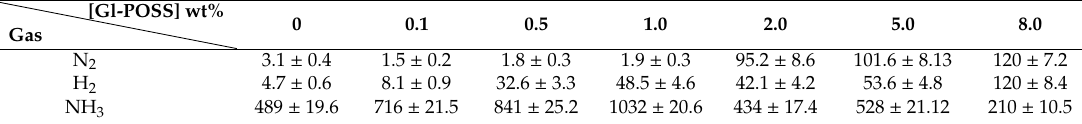
Table 2. The permeability coe ffi cient (P, Barrer) of POI-Gl-POSS membranes, measured at 1.1